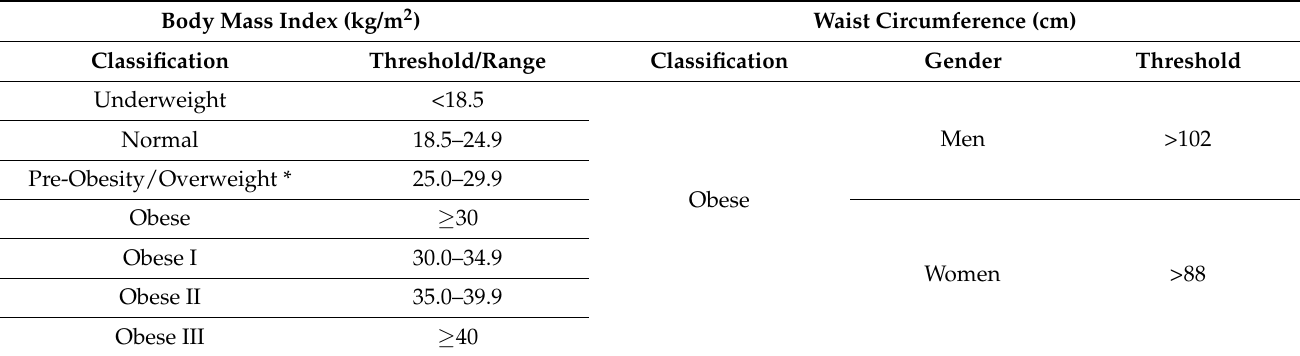
Table 2. Body mass index and waist circumference with standard category thresholds and